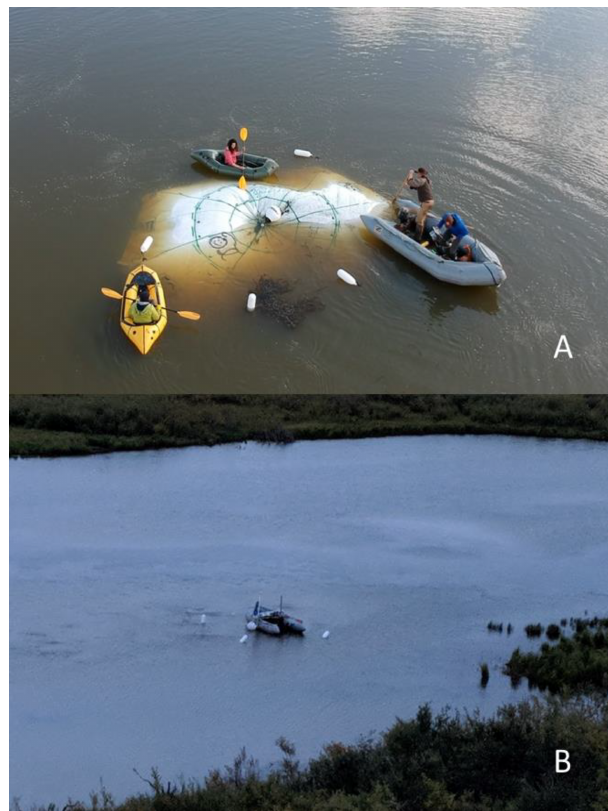
Figure 4. Bubble trap shown during installation before it was sub- merged (a) and during operation (b) ; the inflatable boat contained the measurement device at the center of the submerged bubble trap (credit: Olya Irzak).